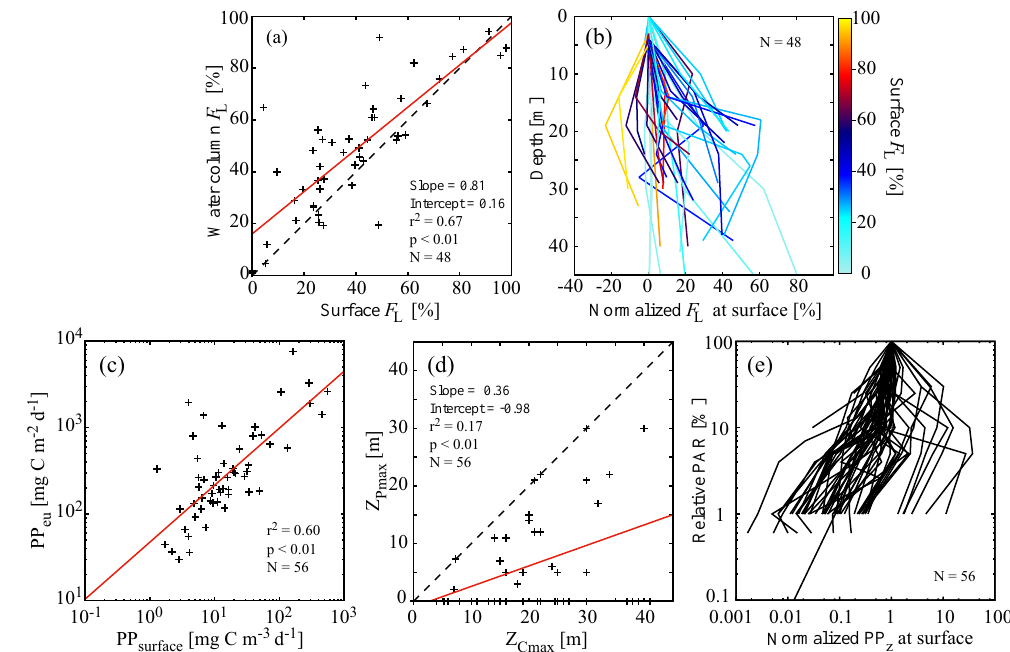
Figure 3. (a) In situ water-column-integrated F L vs. surface F L ( r 2 = 0.67, p <0.01, N = 48), (b) vertical profiles of F L which are normal- ized at surface F L , (c) in situ PP eu vs. in situ surface PP ( r 2 = 0.50, p <0.01, N = 56 in log scale), (d) depth of PP maximum ( Z Pmax ) vs. depth of chl a maximum ( Z Cmax ), and (e) vertical profiles of PP which are normalized at surface PP, respectively. Note that the vertical axis of Fig. 3e indicates %PAR relative to surface PAR value. Vertical profiles of F L are coloured by the surface F L value (Fig. 3b). Dashed lines indicate 1 : 1 line, and red solid lines represent regression lines, respectively.